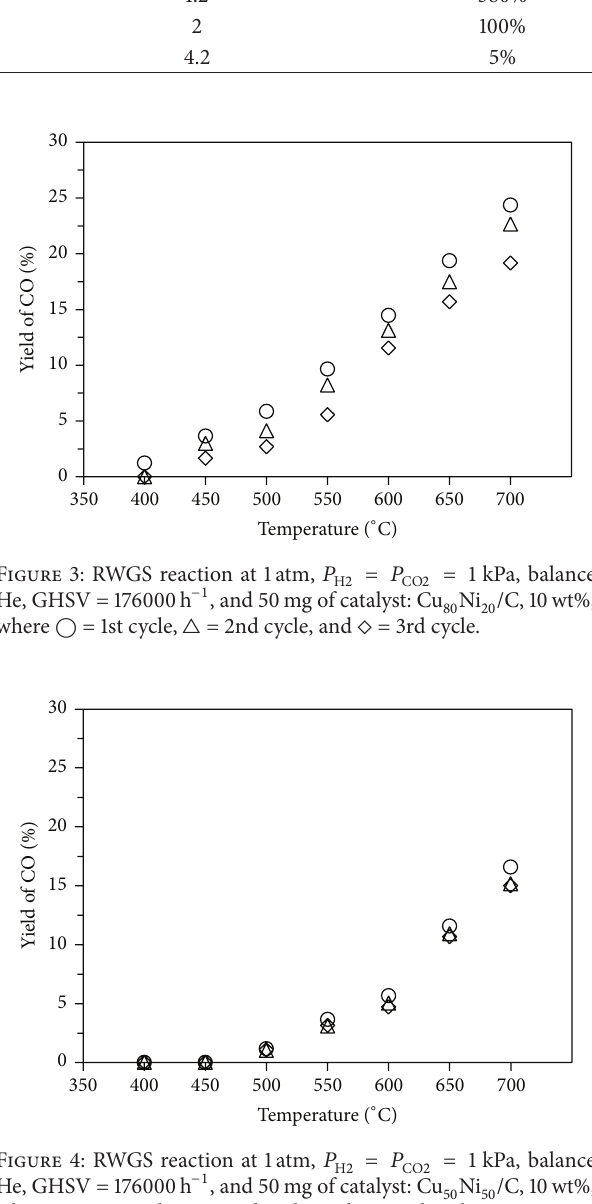
Figure 4: RWGS reaction at 1atm, 𝑃